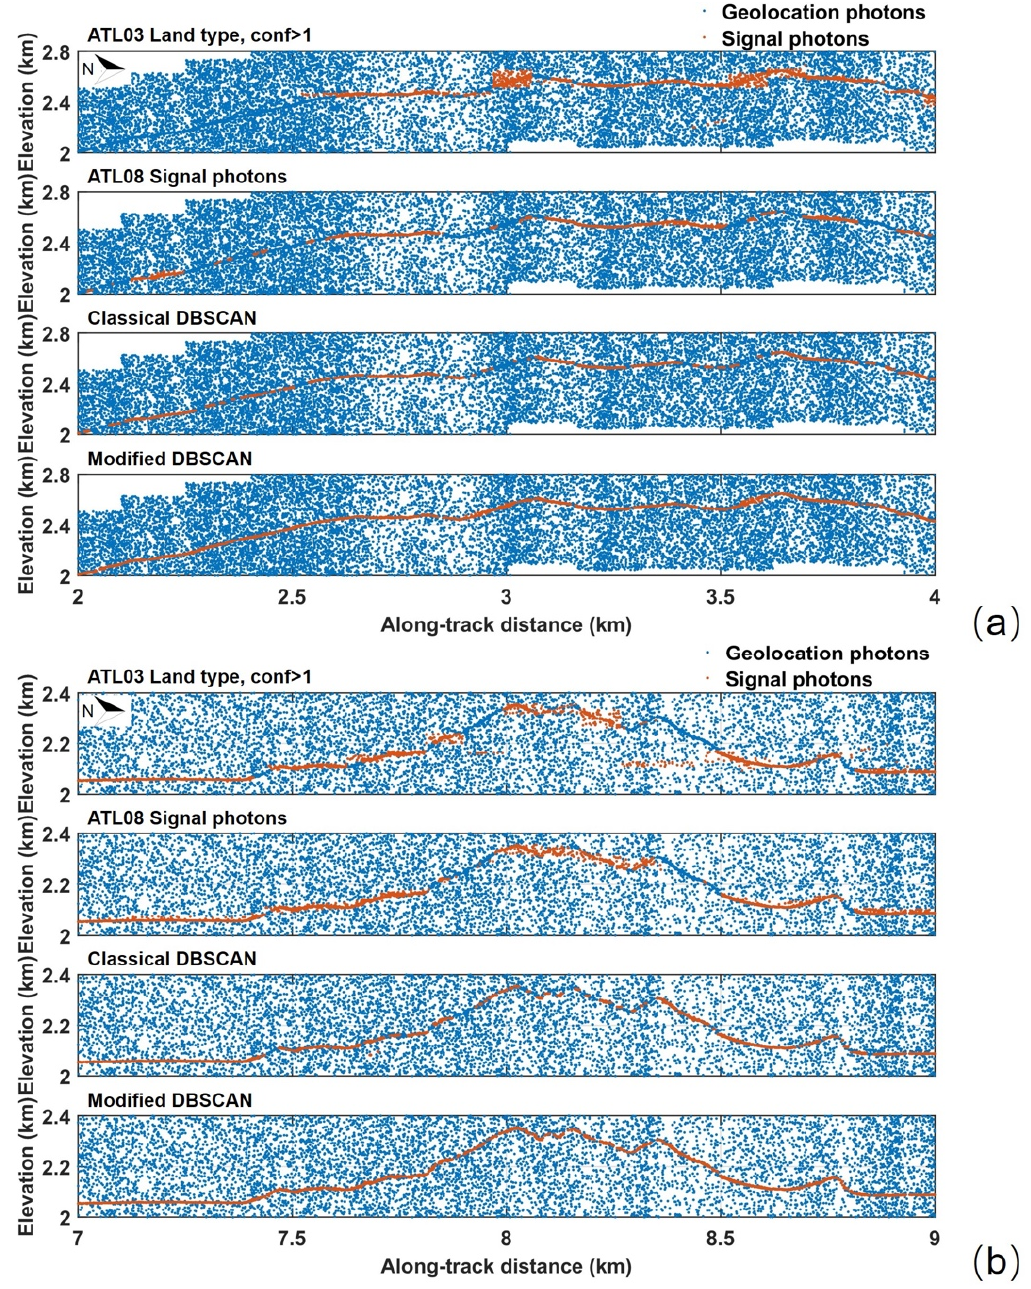
Figure A4. Detailed comparison of the results from the different signal photon extraction methods in the third study area. ( a ) Enlarged along-track segment corresponding to the yellow box in Figure A3a at the along-track distance from 2 km to 4 km. ( b ) Enlarged along-track segment corresponding to the green box in Figure A3a at the along-track distance from 7 km to 9 km.